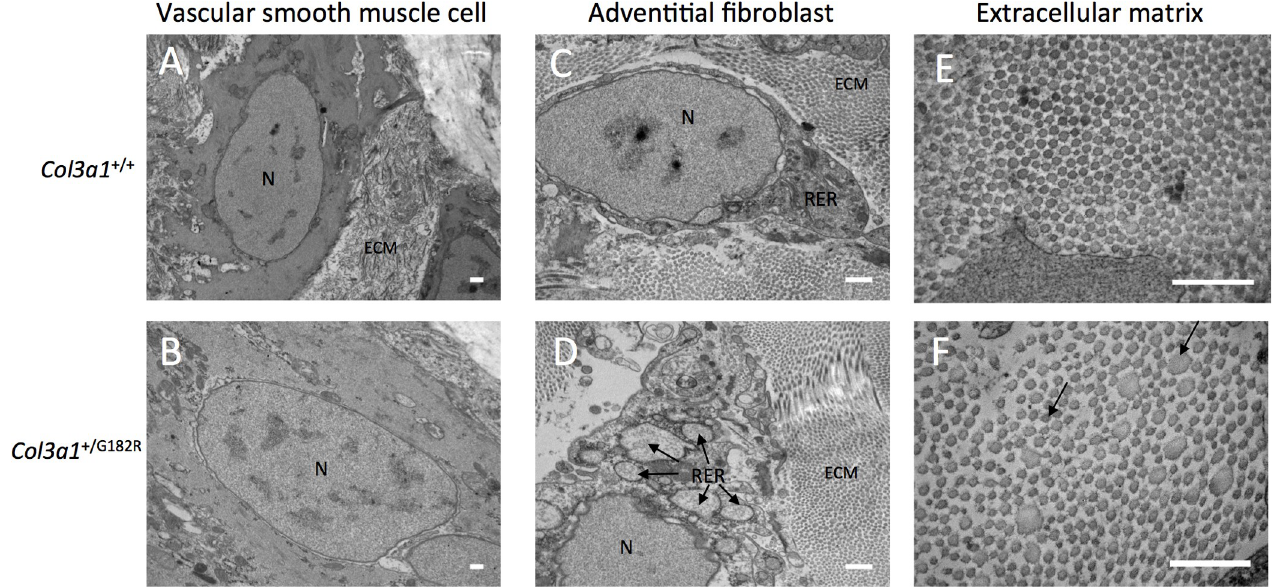
Fig 3. Col3a1 +/G182R aortas have abnormal extracellular matrix architecture. A-F electron microscopy images of the thoracic aorta in 24-week-old Col3a1 +/+ and Col3a1 +/G182R mice (n = 3 per group). N = nucleus, ECM = extracellular matrix, RER = rough endoplasmic reticulum. Scale bar = 500 nm. A-B electron microscopy images of vascular smooth muscle cell in Col3a1 +/+ and Col3a1 +/G182R mice: normal morphology of vascular smooth muscle cell in Col3a1 +/G182R mice. C-D electron microscopy images of adventitial fibroblasts in Col3a1 +/+ and Col3a1 +/G182R mice: black arrows indicate dilated RER in adventitial fibroblasts with intense ribosomal activity in Col3a1 +/G182R mice. E-F electron microscopy images of collagen cross fiber diameter in Col3a1 +/+ and Col3a1 +/ G182R mice: important heterogeneity in diameter and decreased density of collagen fibers in Col3a1 +/G182R mice. Black arrows indicate heterogeneous diameter of collagen